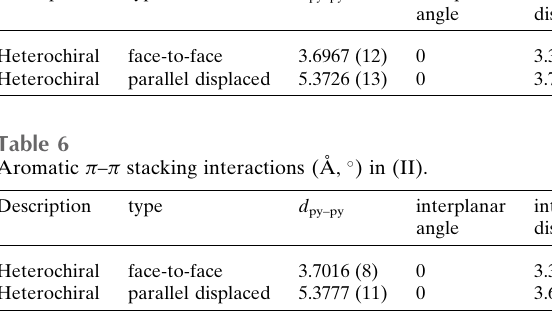
Table 5 Aromatic (cid:2) – (cid:2) stacking interactions (A˚ , (cid:4) ) in (I). Description